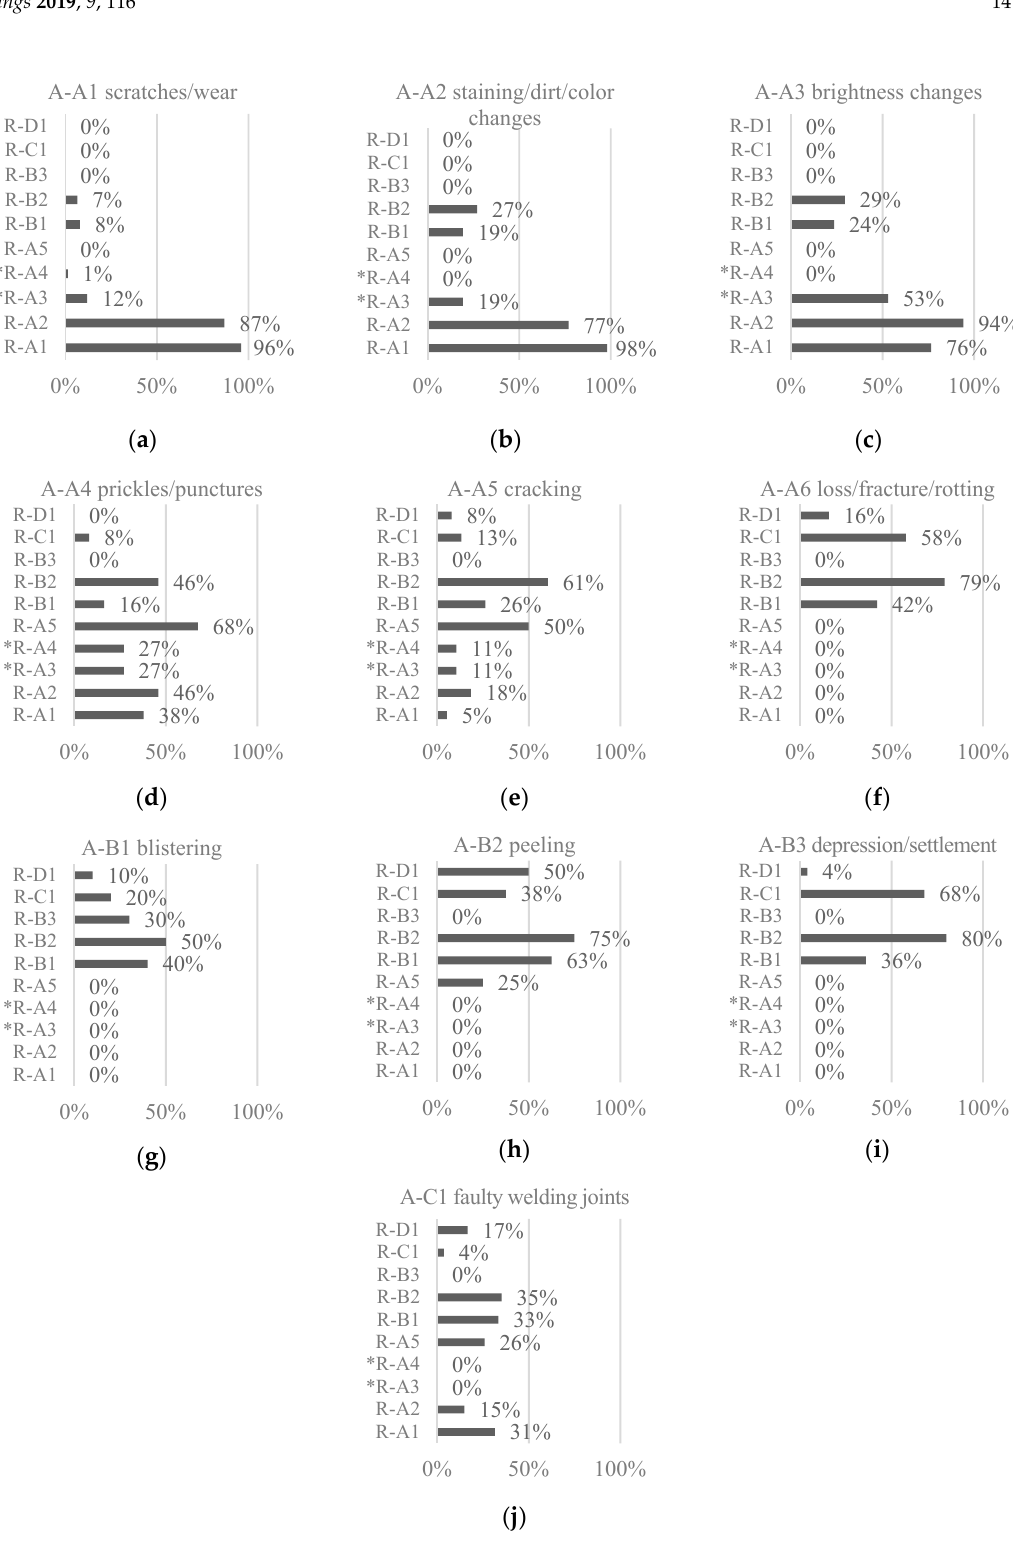
Figure 9. Contribution of each repair technique to each type of anomaly in the sample: ( a ) A-A1 scratches/wear; ( b ) A-A2 staining/dirt/color changes; ( c ) A-A3 brightness changes; ( d ) A-A4 prickles/punctures; ( e ) A-A5 cracking; ( f ) A-A6 loss/fracture/rotting; ( g ) A-B1 blistering; ( h ) A-B2 peeling; ( i ) A-B3 depression/settlement; ( j ) A-C1 faulty welding joints.